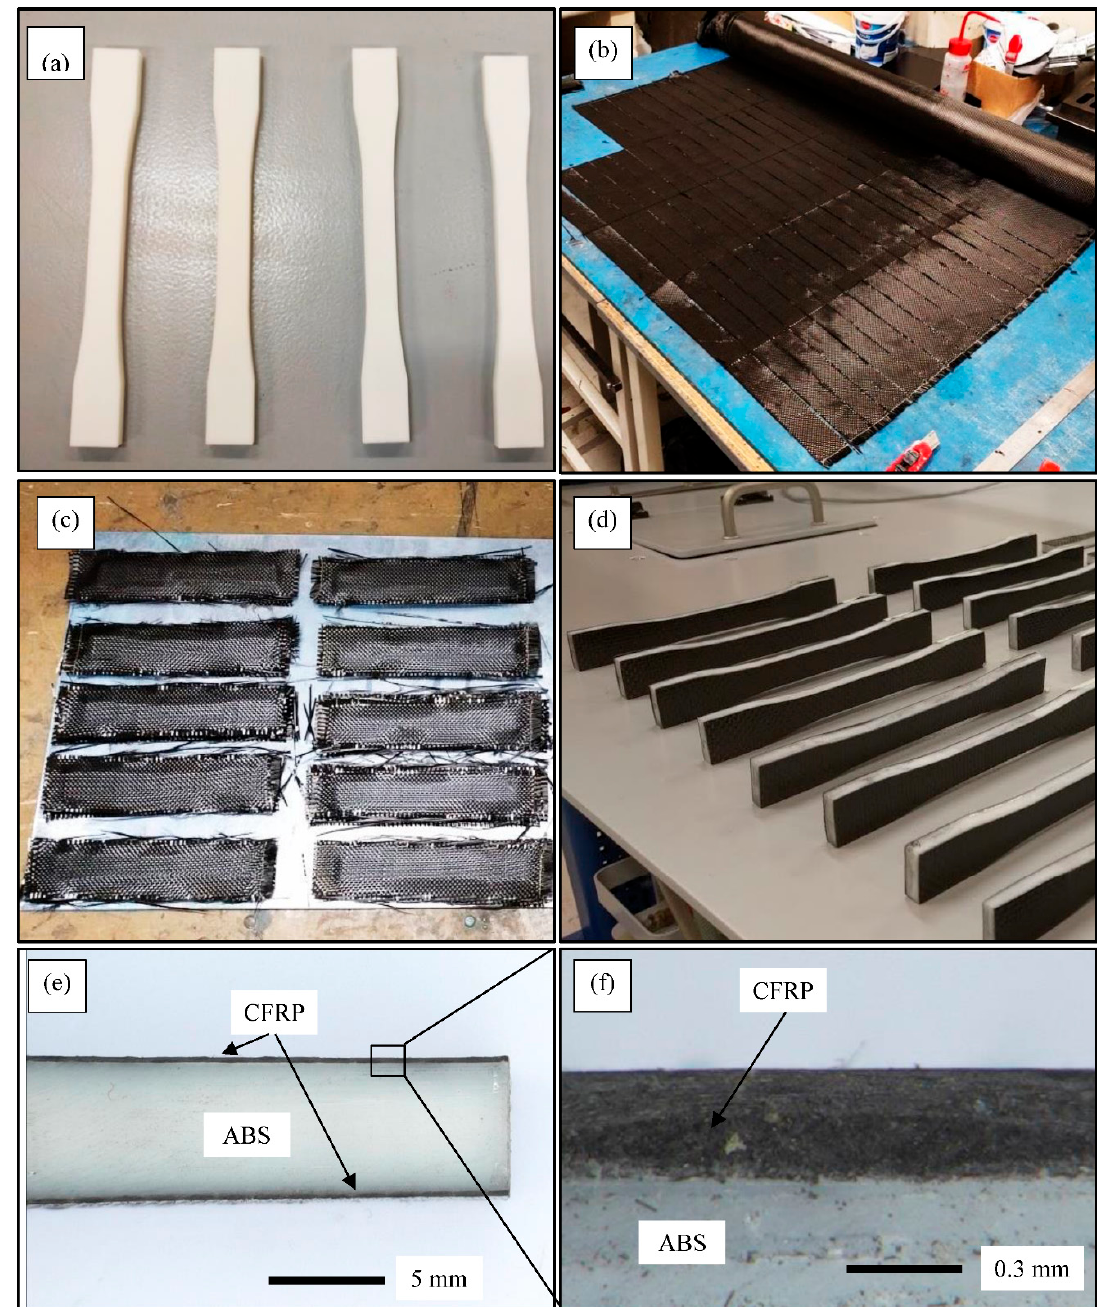
Figure 3. ( a ) ABS 3D printed test samples; ( b ) cut the woven CFRP according to the dimension of each samples; ( c ) glue CFRP layers on ABS surface and left to cure; ( d ) ABS/CFRP/ABS sandwich